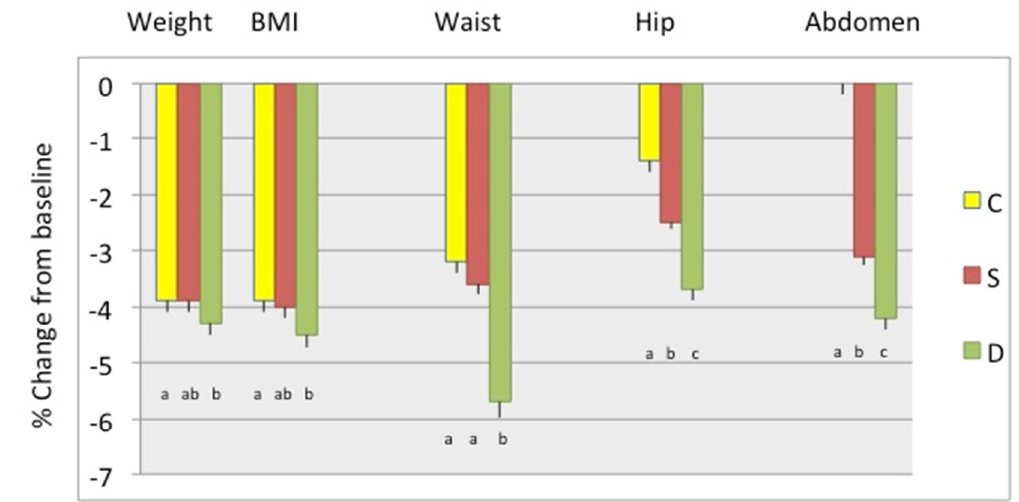
Figure 2. Percent change (mean ± SEM) in weight (kg), BMI (kg / m2), waist, hip, and abdominal circumference (cm), respectively, between baseline and 6 months among the groups. Only the complete data sets at baseline and 6-months were used. C-Control / placebo, n = 30; S-Supplement, n = 37; D-Dairy, n = 30. Bars with di ff erent letters indicate the statistically significant di ff erence among the groups at 6